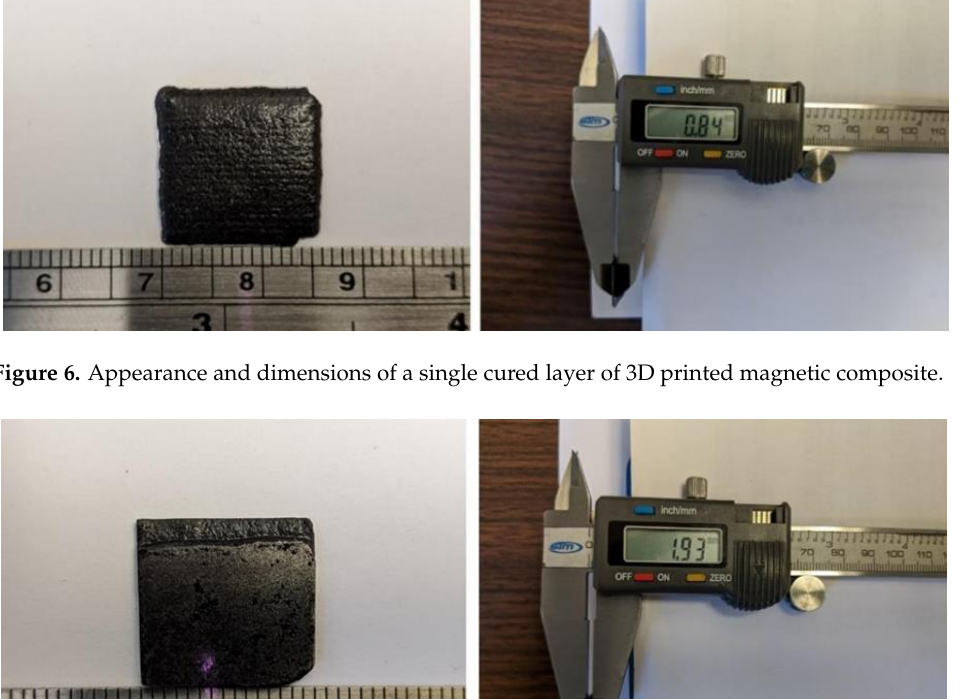
Figure 5. ( A ) Material jetting equipment with the in-situ particle alignment system and ( B ) UV source irradiating polymer sample for curing.